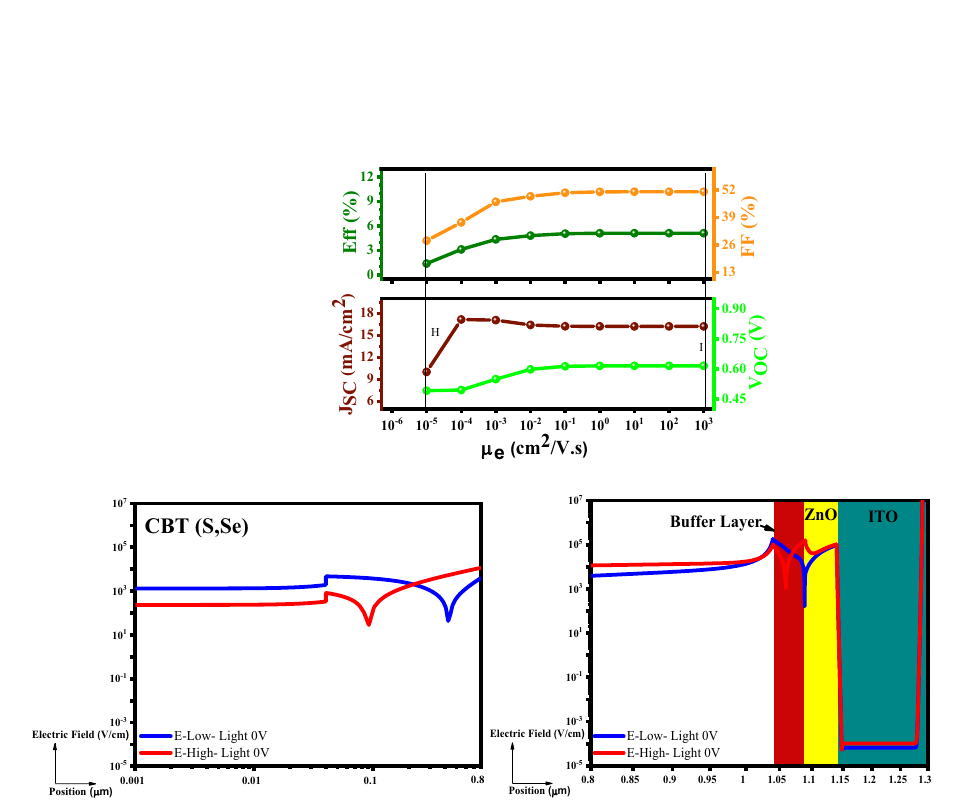
Figure 9. Variation of the solar cell parameters of the CBT (S, Se) solar cells with different μ e of In 2 S 3